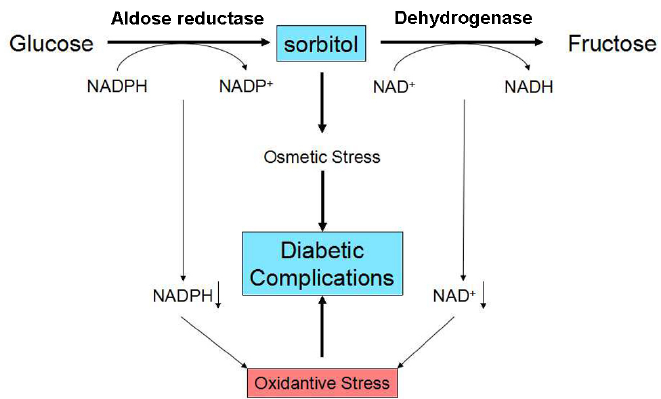
Figure 1. Polyol pathway and pathogenesis of diabetic complications.